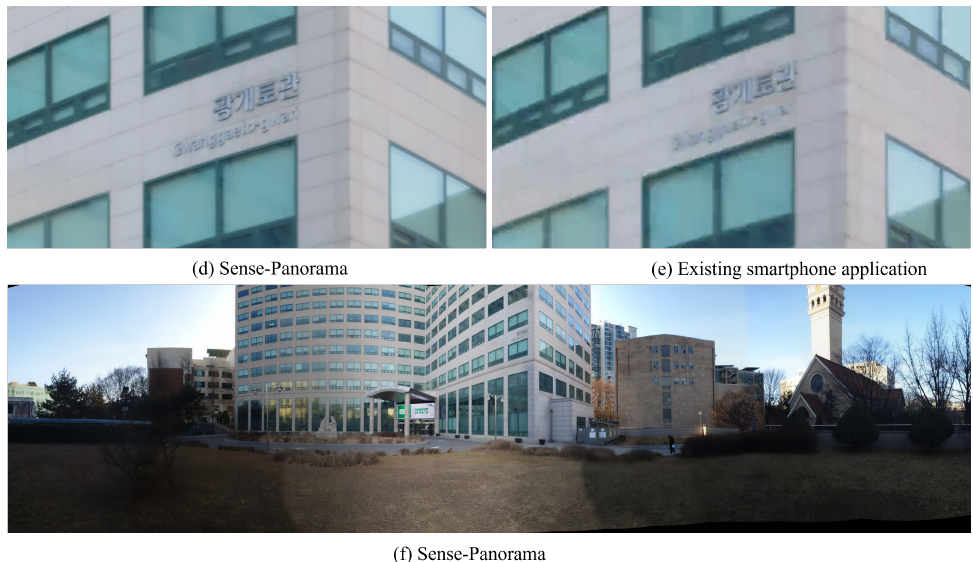
Figure 12. ( a , b ) show a comparison between Sense-Panorama and the existing smartphone applica- tion, ( c ) is a complete panoramic image shot taken by Sense-Panorama. Similarly ( d ) and ( e ) show a comparison between Sense-Panorama and the existing smartphone application, ( f ) is a complete panoramic image shot taken by Sense-Panorama.